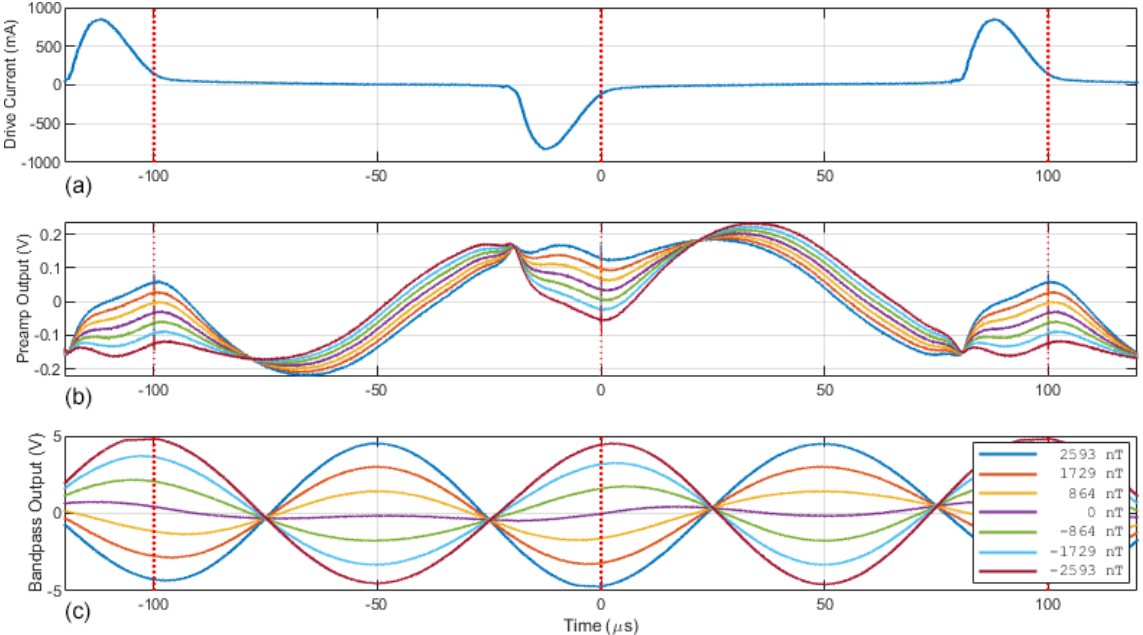
Figure 6. (a) Drive current periodically saturating the ring. (b) Output of the pre-amplifier. (c) Output of bandpass filter at 2F frequency. Colors show modulation due to different applied